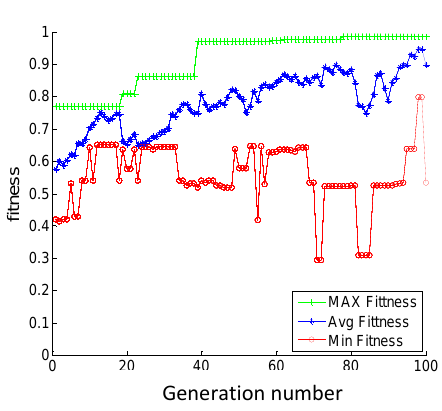
Figure 6. Circuit for F 2